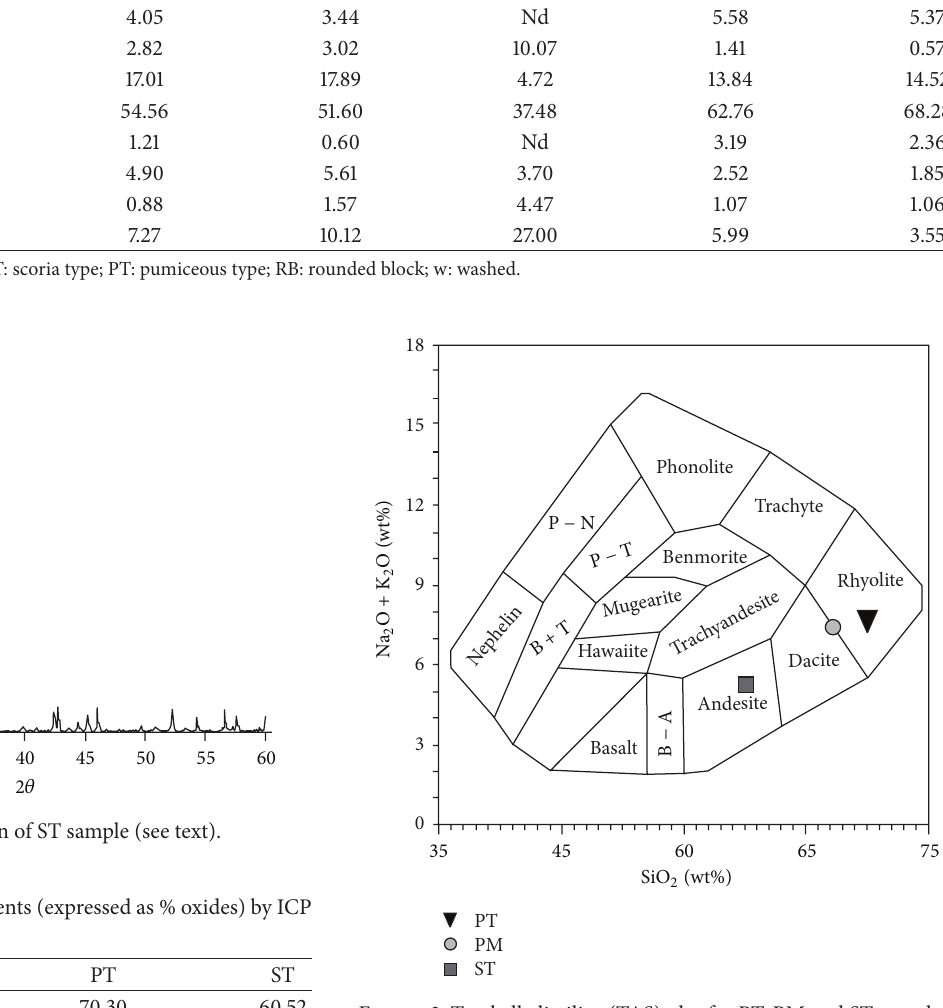
the order PT < ST < RB, whereas the PM pyroclastic material reveals the contribution of the mixture components. Rounded blocks (RB), of intense black color, are the Fe and Ti richest samples. Dark color can be associated with the Fe(II)- Fe(III) intervalence charge transfer process